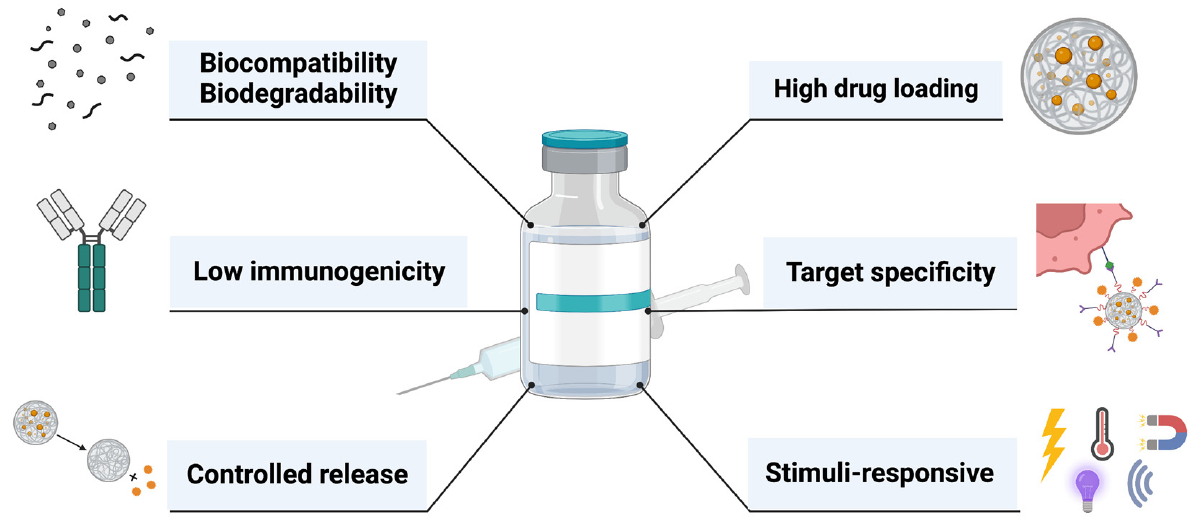
Figure 3. Features of an ideal MIP as DDS. This illustration shows the most important features for MIPs as DDS, which include their biocompatibility, biodegradability, low immunogenicity, con- trolled release, high drug loading, target specificity and stimuli-responsiveness.